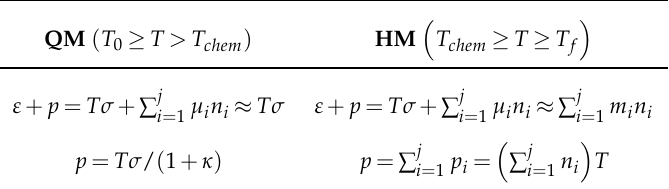
Table 1. We assume, that at high temperature, the enthalpy density is dominated by the entropy term while below the chemical freeze-out temperature of hadrons, their rest mass dominates the same term. In these equations, j counts how many kinds of different hadrons are hadrochemically